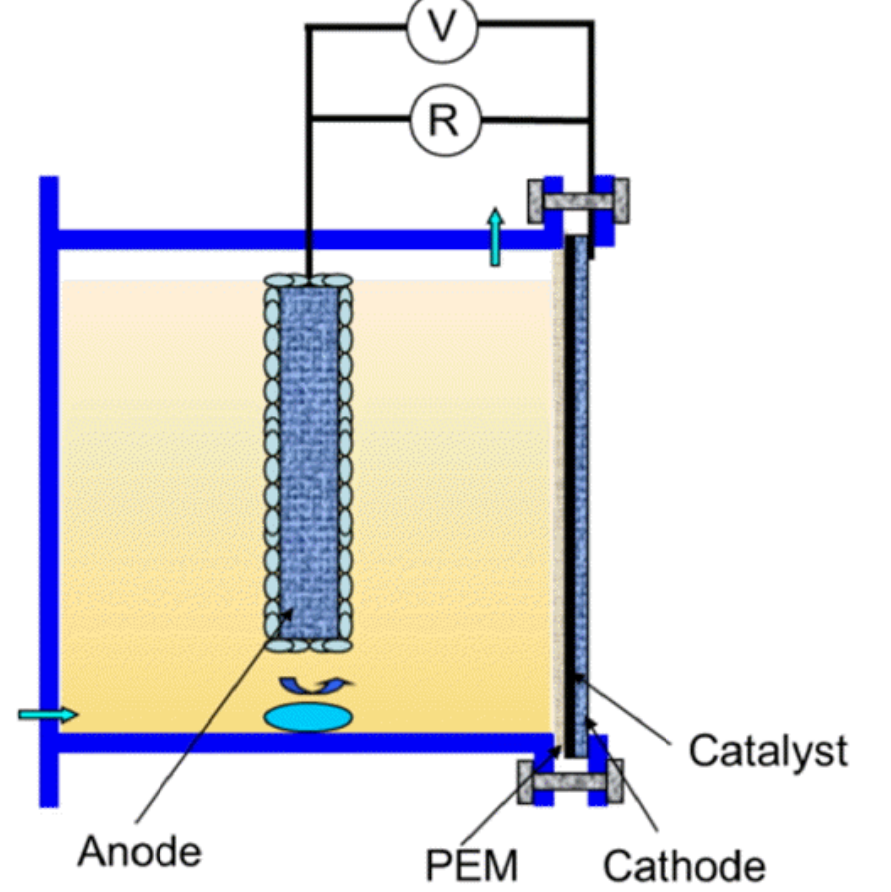
Figure 5. Schematic of the air-cathode MFC reactor (Reprinted with permission from Ref.